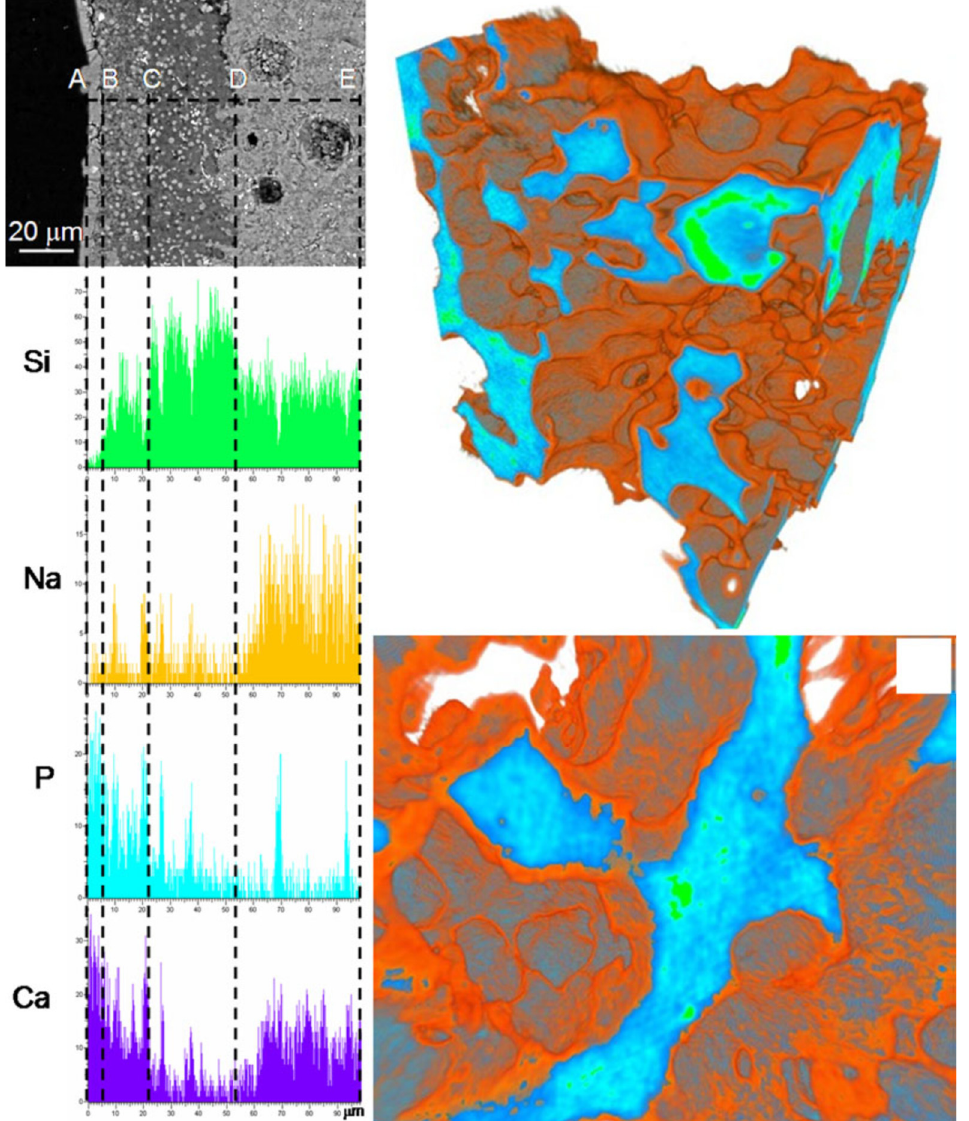
Figure 5. Results of in vitro bioactivity test on a silicate glass-ceramic scaffold: SEM-EDS analyses on a cross-section (left) and micro-tomographic three-dimensional reconstructions (right) after 14 days of immersion in SBF. Reproduced from [113] Miola, M.; Verné, E.; Vitale-Brovarone, C.; Baino, F.